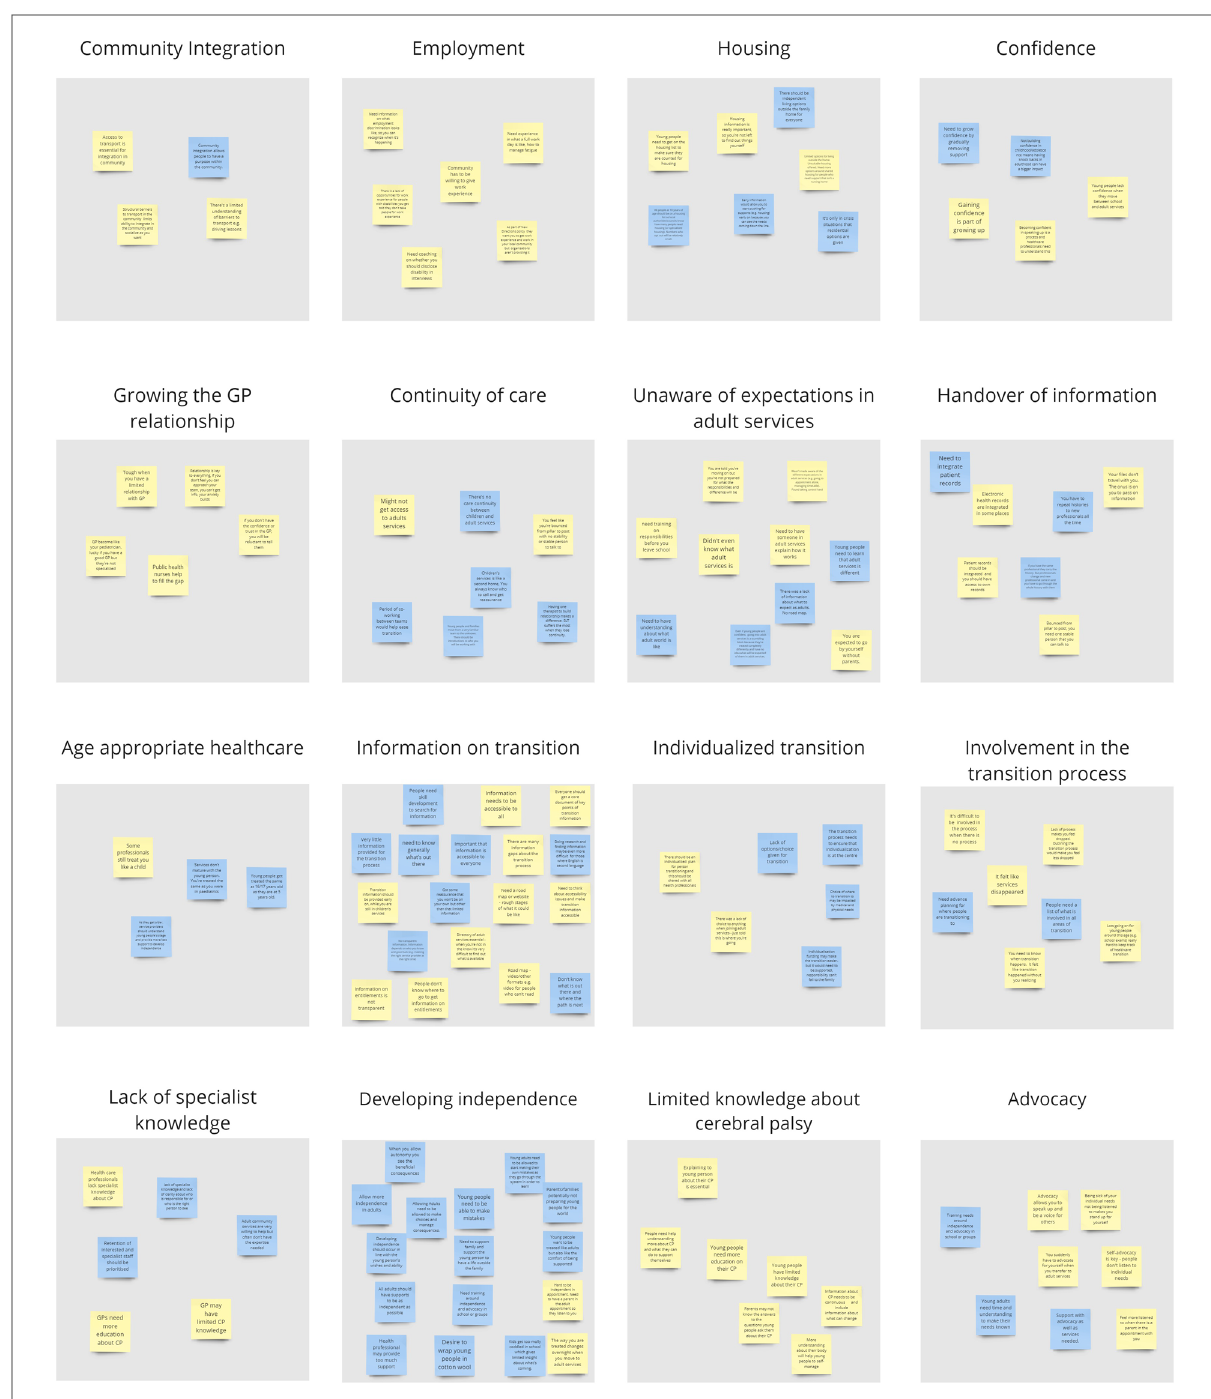
FIGURE 3 Themes generated by YPAG (yellow post-its) and PAG (blue